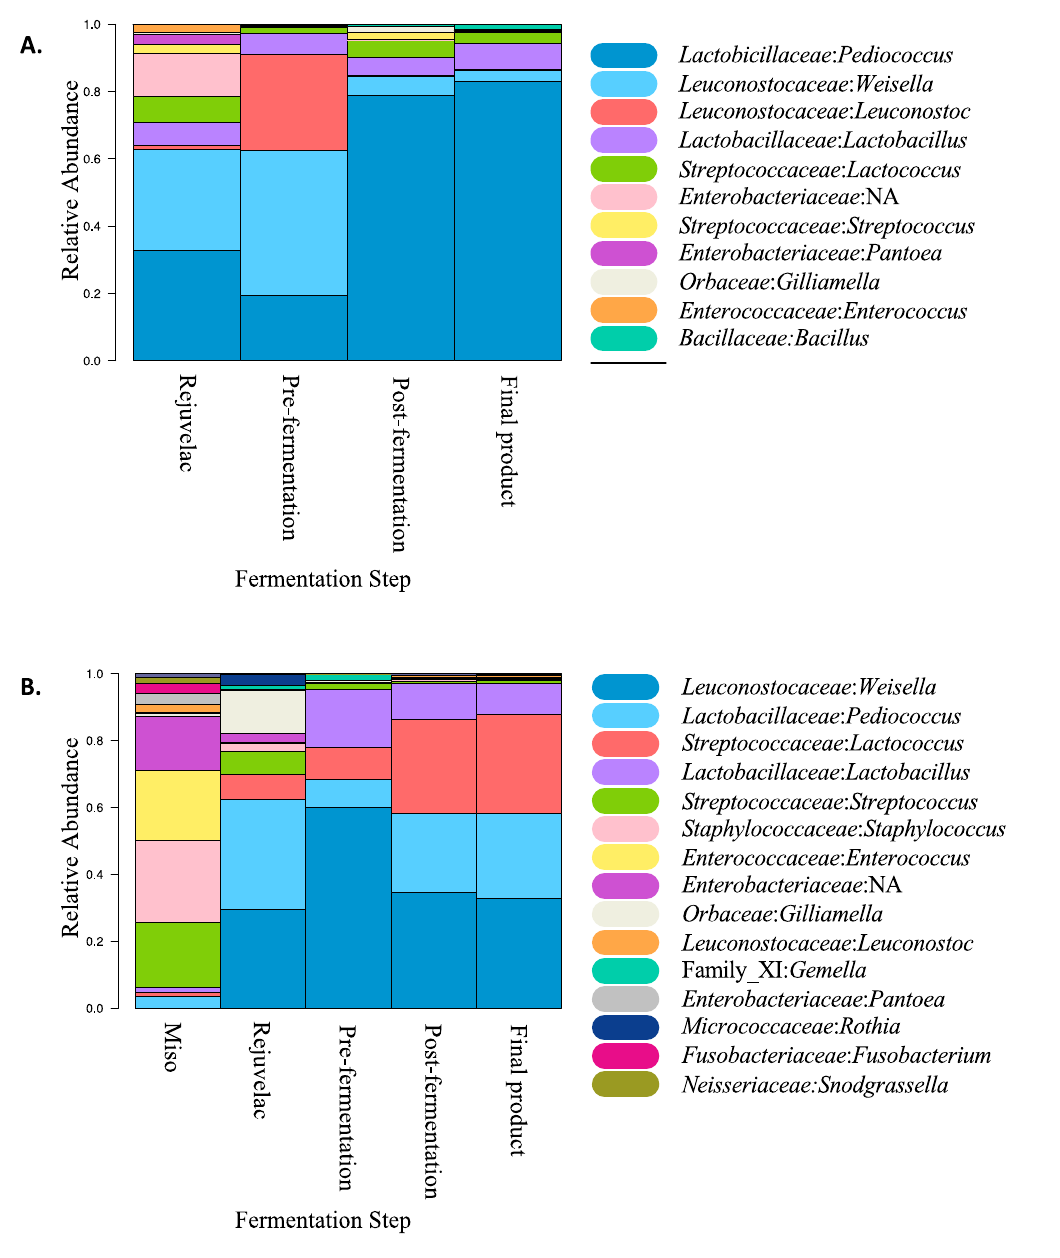
Figure 4. Relative microbiota compositions of fermented cashew products ( A ) ‘brie’ and ( B ) ‘blue’. The V4 region of the 16S rRNA gene was selected for PCR.